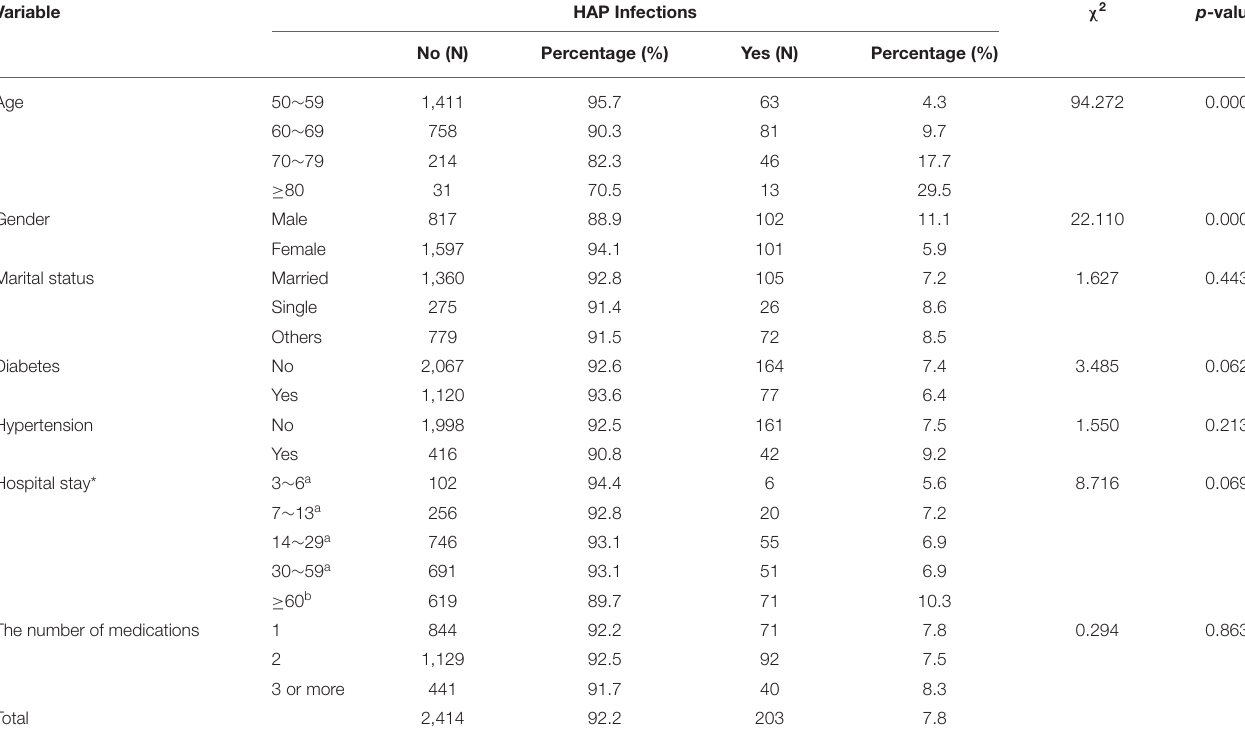
TABLE 1 | Personal characteristics of HAP infection or not in hospitalized patients with schizophrenia ( N = 2,617).